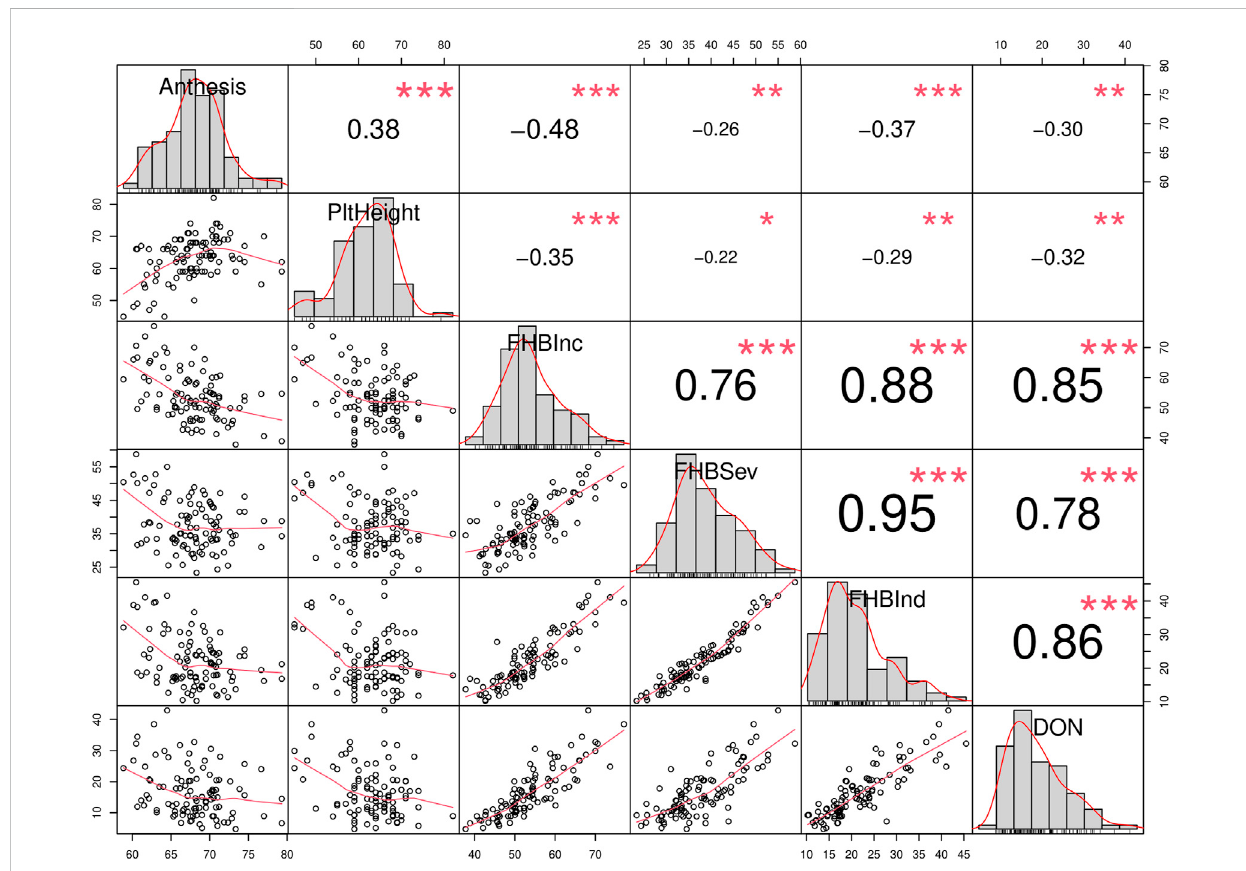
FIGURE 3 Correlation matrix of traits related with Fusarium head blight (FHB): Anthesis (days), Plant height (PltHeight, cm), incidence (FHBInc, %), severity (FHBSev,%),index(FHBInd,%)andDeoxynivalenol(DON,ppm).Thedistributionofeachvariableisshownonthediagonal.Onthebottomofthediagonal, the bivariate scatter plots with a fi tted line are displayed. On the top of the diagonal, the value of the correlation plus the signi fi cance level as stars. Each signi fi cance level is associated to a symbol: 0.001: “ *** ” , 0.01: “ ** ” , 0.05: “ * ” . The data is derived from the evaluation of Brazilian cultivars grew at Ottawa 2021 and at Morden 2017 and 2018 under arti fi cial inoculation and